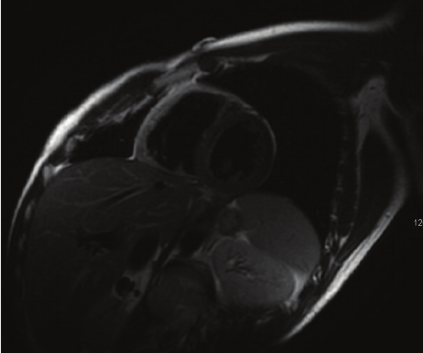
Figure 1: T2 weighted image showing diffuse RV